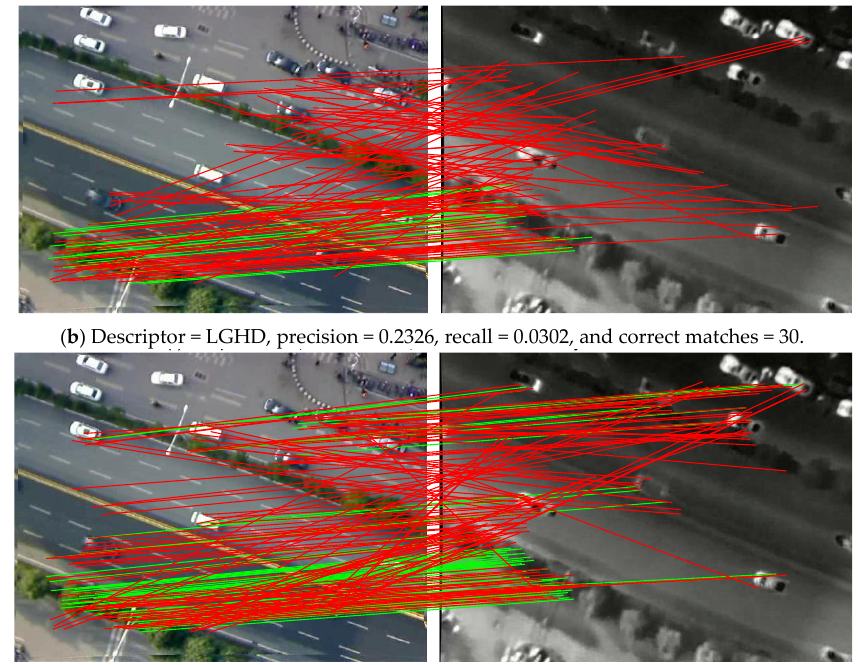
Figure 18. The correctly matched (green lines) and falsely matched (red lines) results for SURF ( a ), LGHD ( b ), and our HOMPC ( c ) descriptors. The displayed green and red lines are used to visually compare the descriptor performance. The greater number of the green lines, the better. The higher the ratio of the green lines, the better. The quantitative results are also listed below each pair of images.